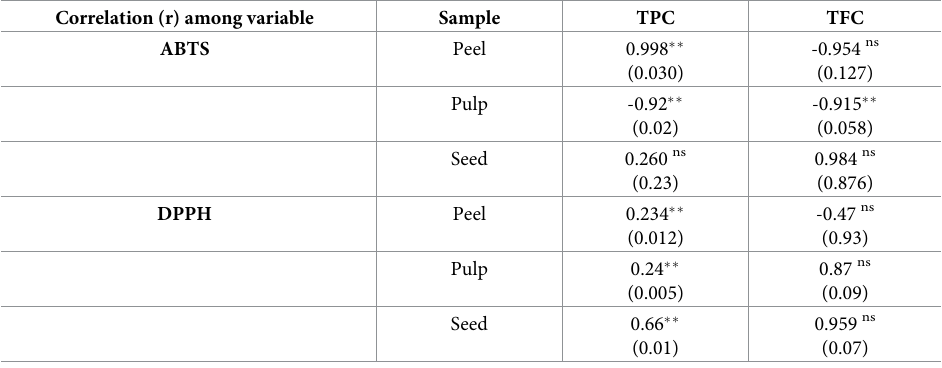
Table 6. Pearson correlation among EC50 of DPPH and ABTS radical scavenging activity and TPCs and TFCs. Correlation (r) among variable Sample TPC TFC ABTS Peel 0.998 �� (0.030) (0.127) Pulp -0.92 �� -0.915 �� (0.02) (0.058) Seed 0.260 ns (0.23) (0.876) DPPH Peel 0.234 �� (0.012) (0.93) Pulp 0.24 �� (0.005) (0.09) Seed 0.66 �� 0.959 ns (0.01) (0.07) r, correlation coefficient; TPC, total phenolic content; TFC, total flavonoid content; DPPH, DPPH radical scavenging activity; ABTS, 2, 2´-azino-bis (3-ethylbenzthiozoline-6)-sulphonic acid method. The numbers in parentheses are p- values. �� Correlation is significant at the 0.01/0.05 level (two-tailed), ns = not